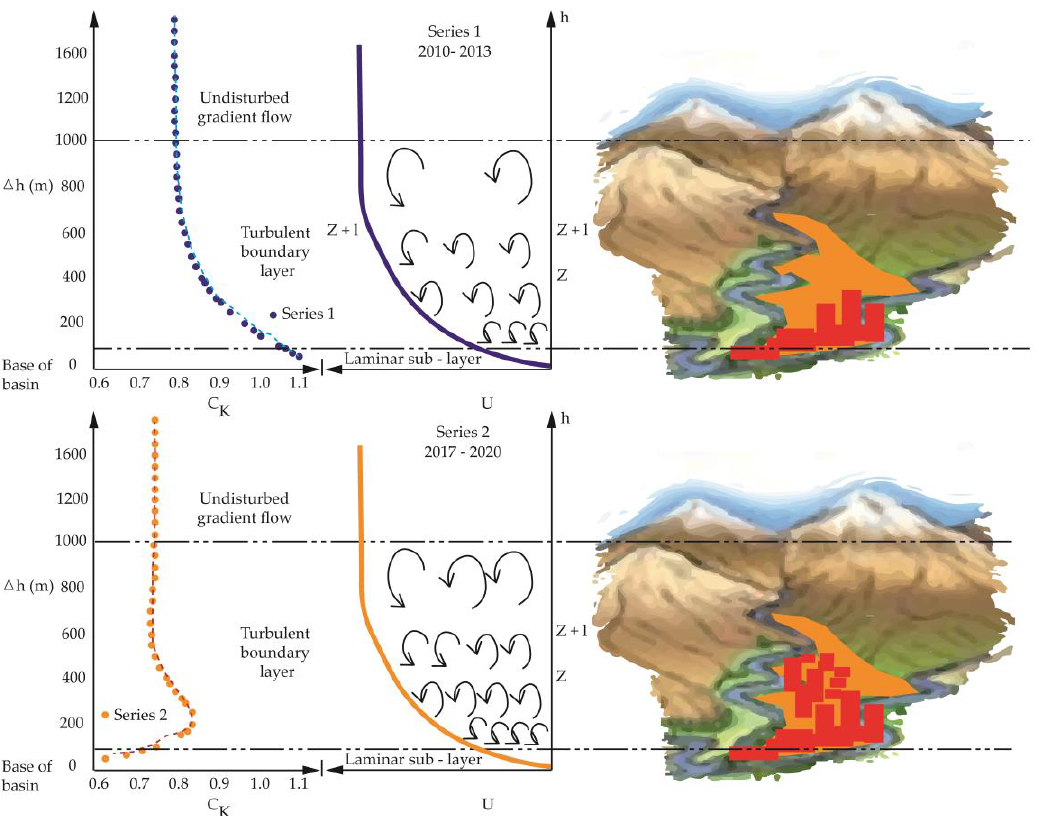
Figure 8. The upper figure represents the period 2010 – 2013, which is considered the beginning of the intensive urban densification process, mainly due to high-rise buildings. The lower figure shows the result of the continuity and increase in densification (period 2017 – 2020). Δh = h − 469 (m).